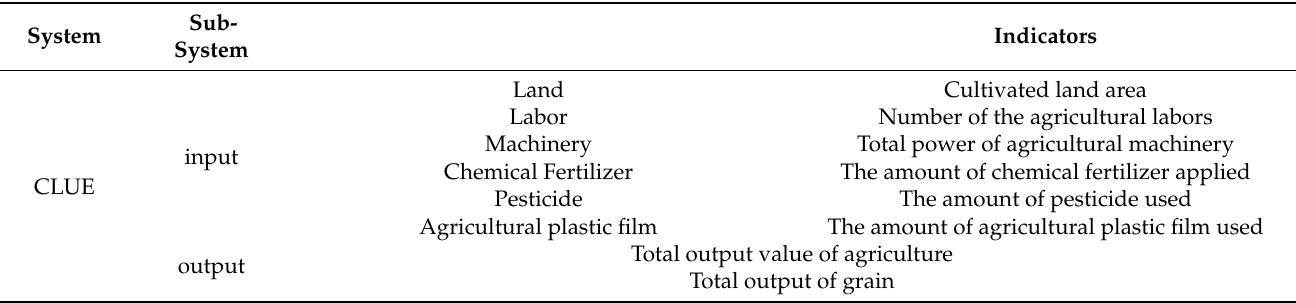
Table 1. The indicators of CLUE.